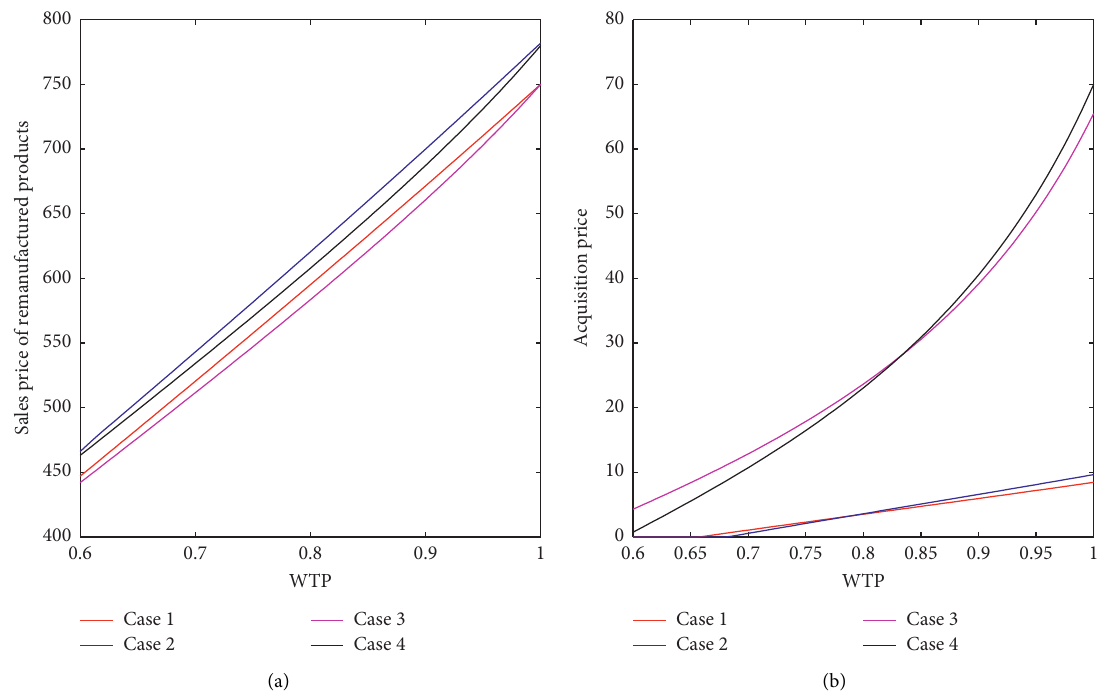
Figure 9: (a) Sales price for remanufactured products and (b) acquisition price for used products vs.